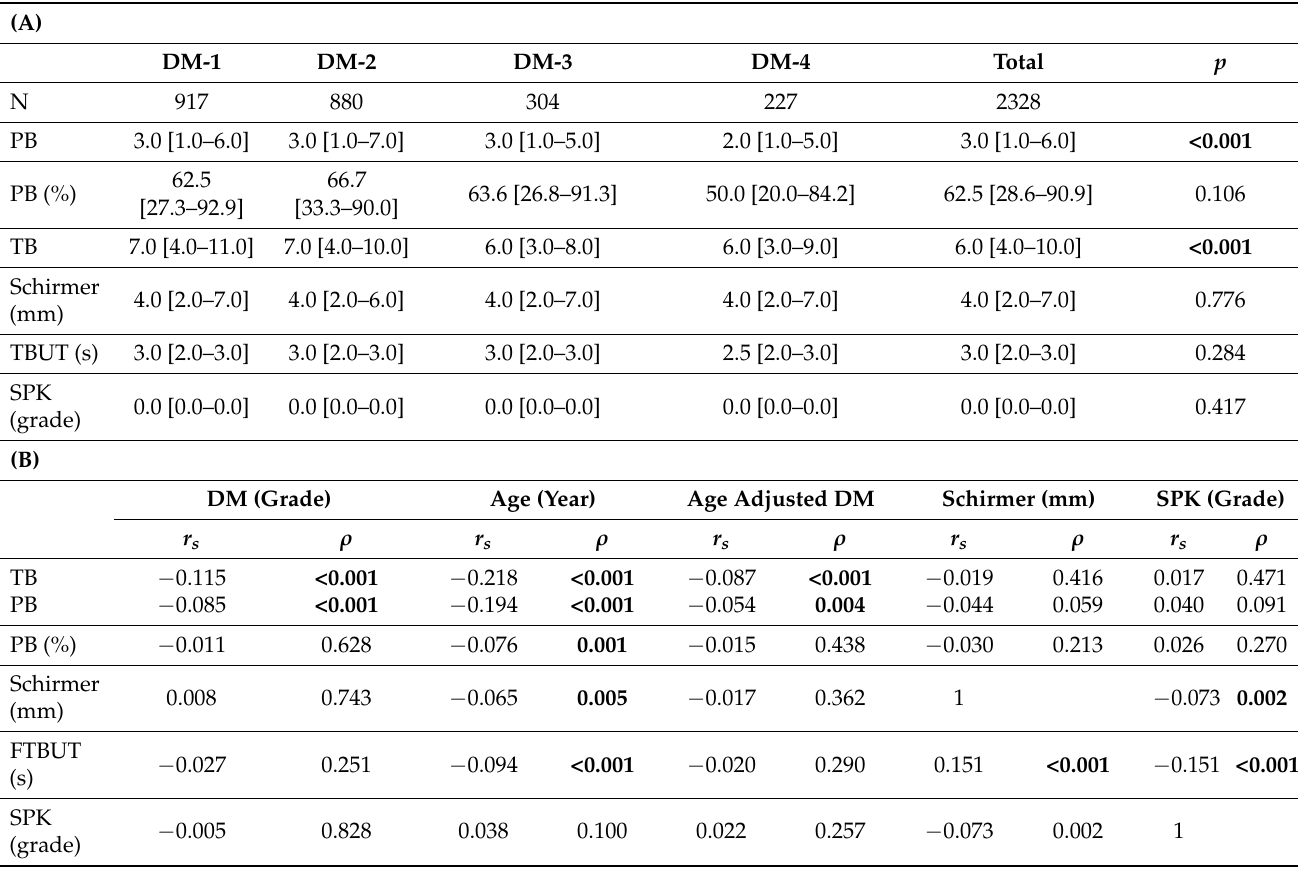
Table 5. Summary and correlation of tear-film, blink patterns, and corneal parameters (A). Sum- mary of tear-film, blink patterns, and corneal parameters according to dermatochalasis severity (B) Correlations among dermatochalasis, age, blinks, and tear-film parameters.